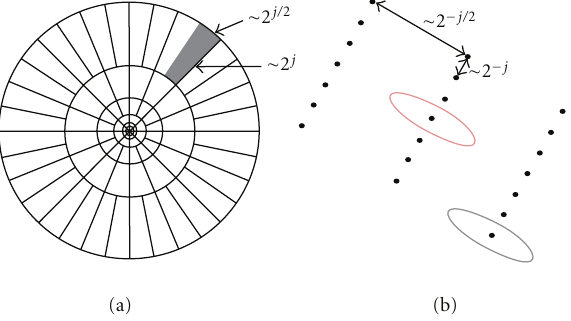
Figure 8: Curvelet tiling of space and frequency. The induced tiling of the frequency plane (a). The spatial Cartesian grid associated with a given scale and orientation (b).